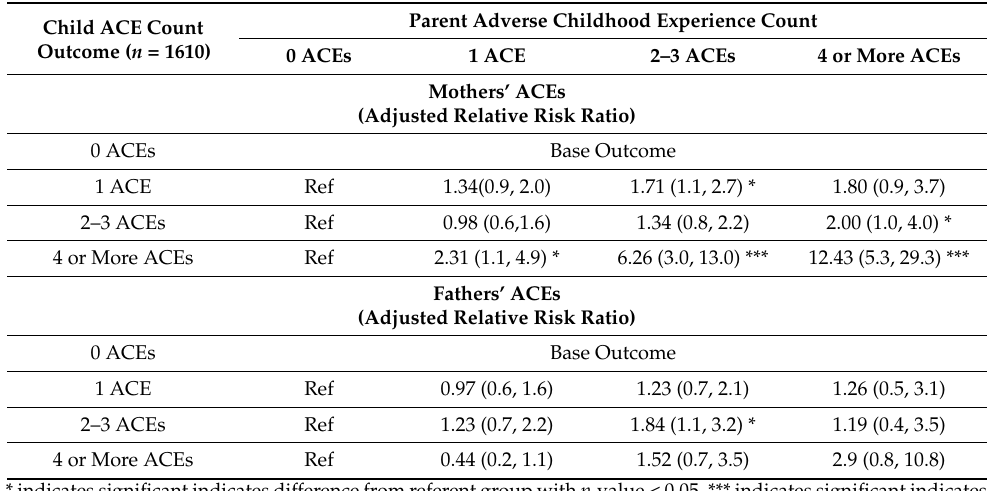
Table A2. Differences in Adjusted Relative Risk Ratios of Child Adverse Childhood Experiences Count by Mothers’ or Fathers’ Individual Adverse Childhood Experience